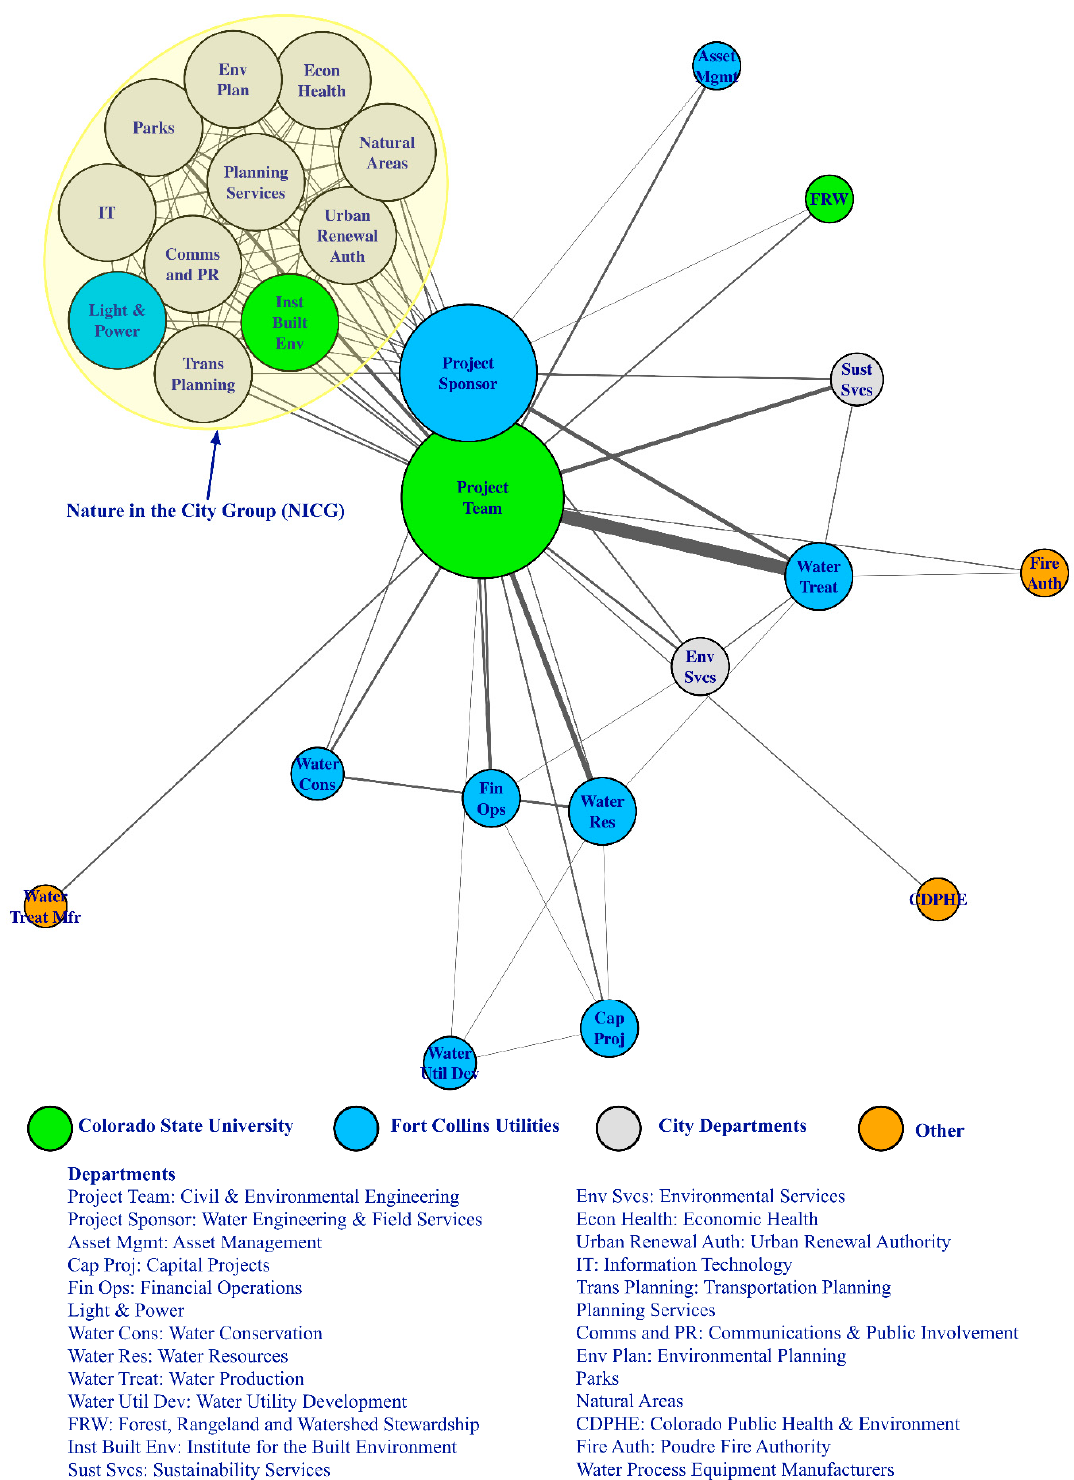
Figure 7. Knowledge sharing among study participants (Force-directed graph using Fruchterman & Reingold algorithm. Nodes represent the 26 departments/organizations involved in the study. Node size represents the number of shortest paths going through that department (betweenness centrality) (igraph R package). Connections represent knowledge sharing communications. Thickness of connections represent the number of communications. Meetings, workshops, and phone conversations were represented as reciprocal communications and emails as unidirectional communication).